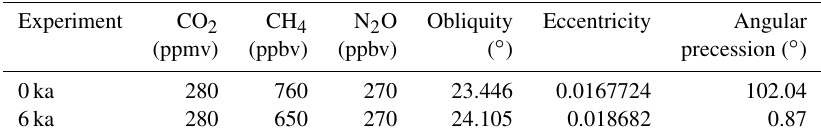
Table 1. The boundary conditions (trace gases) and orbital parameters for the 0 and 6ka PMIP